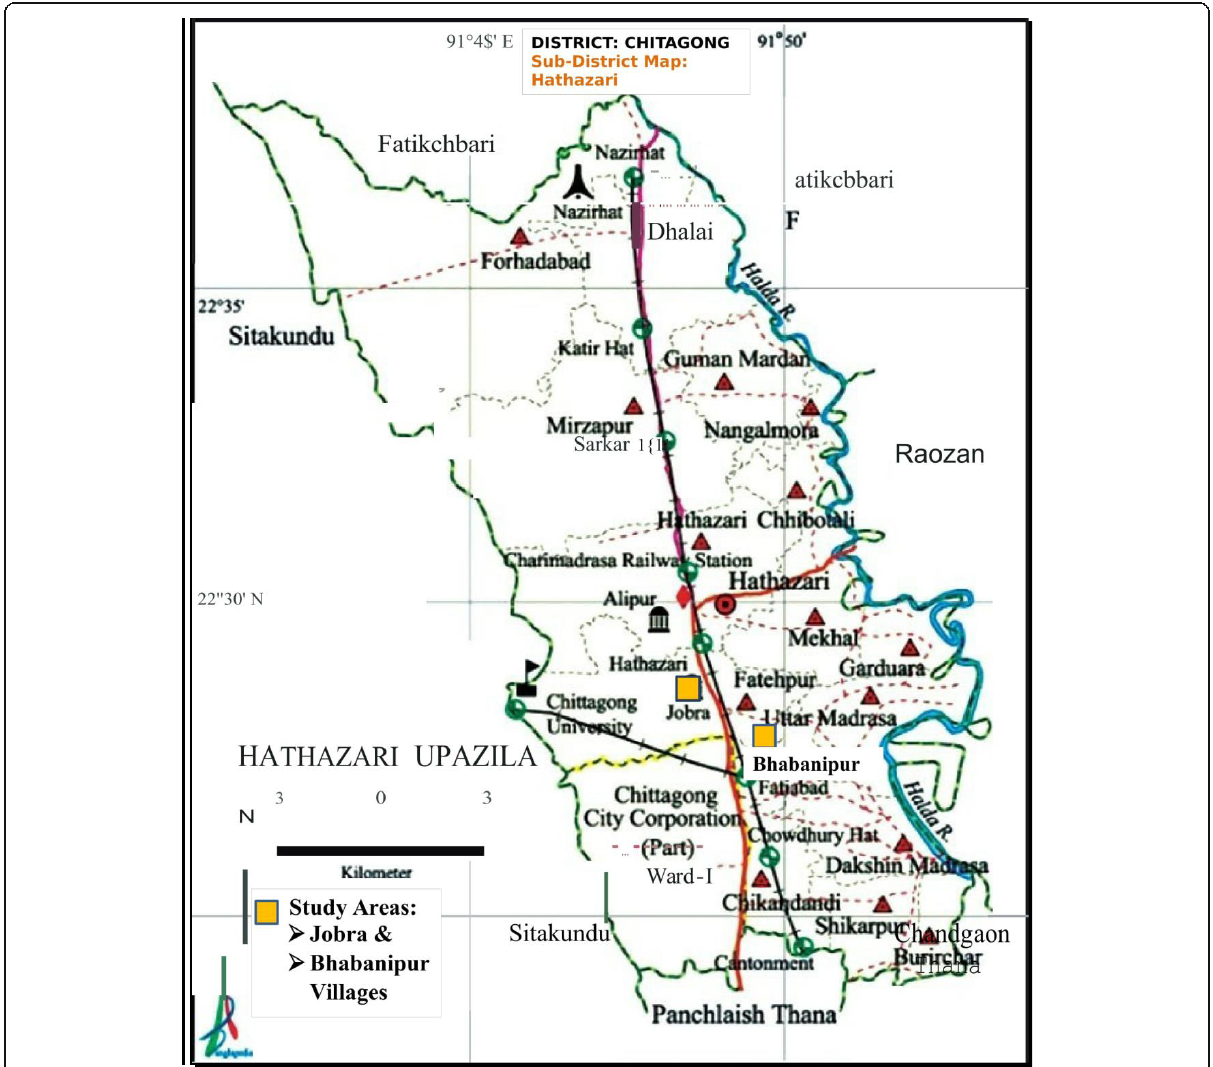
Fig. 1 Study Areas: Jobra and Bhabanipur villages in Hathazari sub-district of Chittagong district, Bangladesh [Adapted from Google Map] (Source: https://www.google.com/search?q=map+of+hathazari+upazila&client=firefox-b-ab&source=lnms&tbm=isch&sa=X&ved=0a-